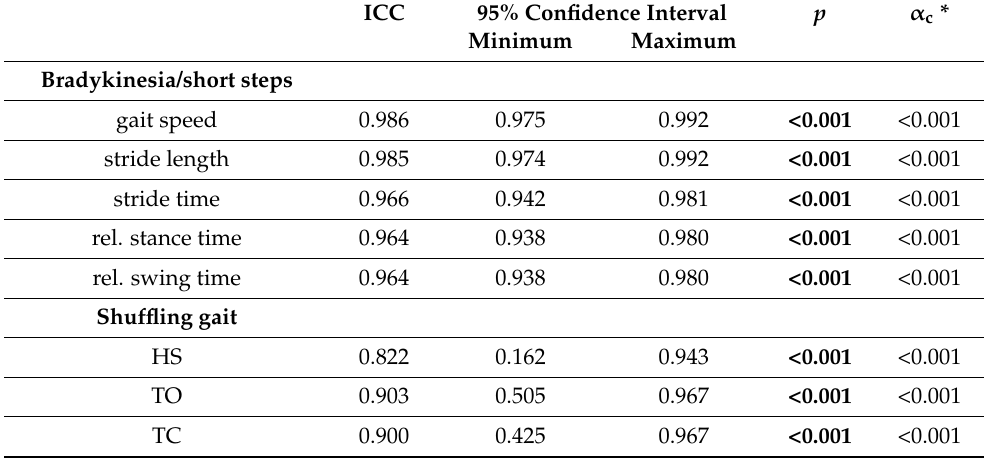
Table 2. Inter-class correlation coefficient (ICC); maximum and minimum of 95% confidence interval.